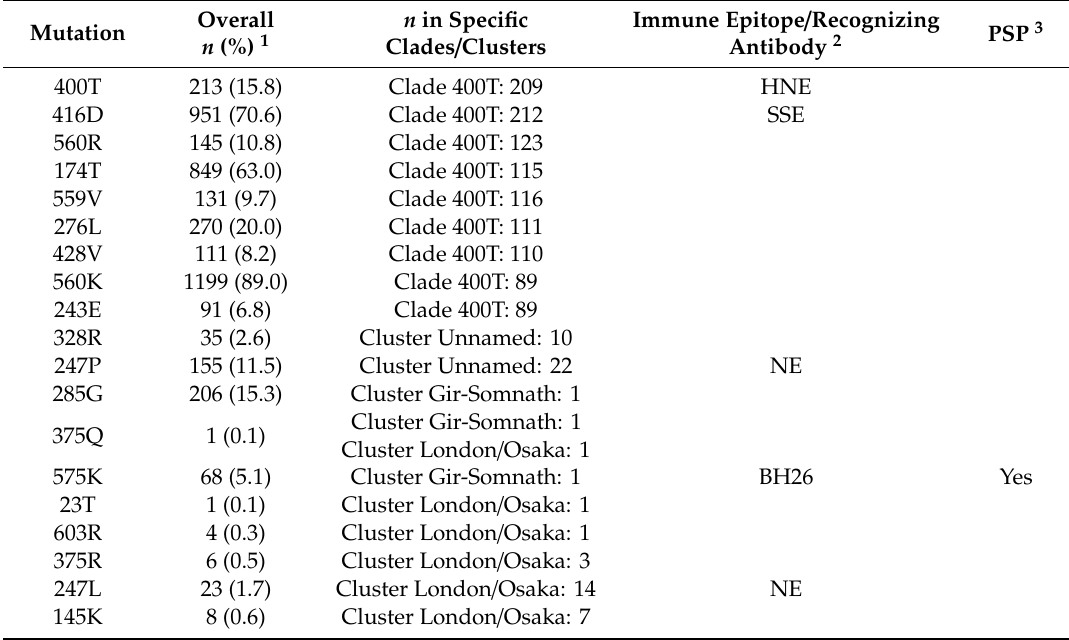
Table 3. Frequency of amino acid mutations involving D8 strains from